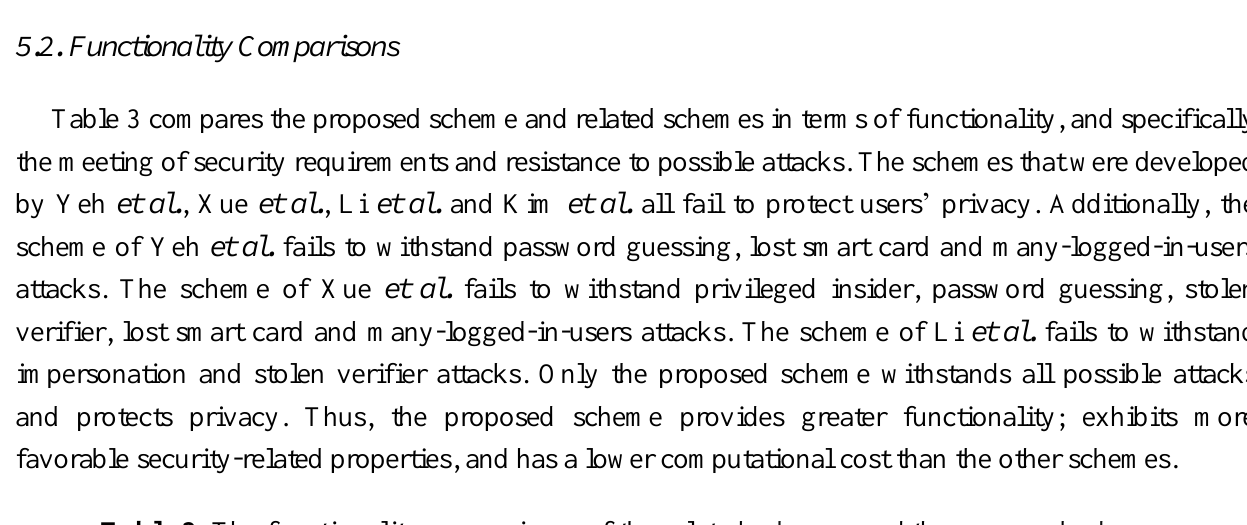
Table 3. The functionality comparisons of the related schemes and the proposed scheme. Yeh et al.